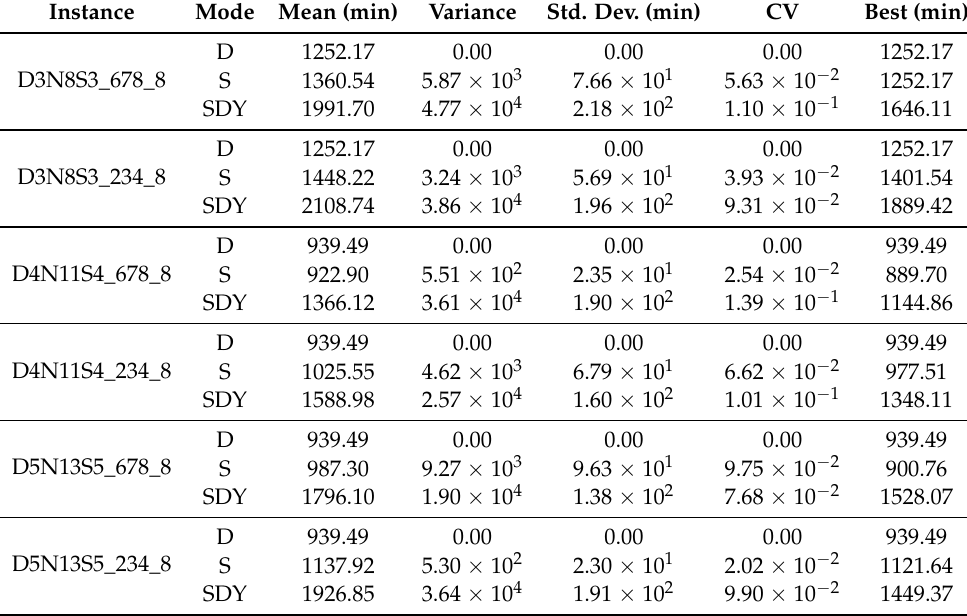
Table 9. Results of Total Travel Time with (Maximum) 8 Vehicles.